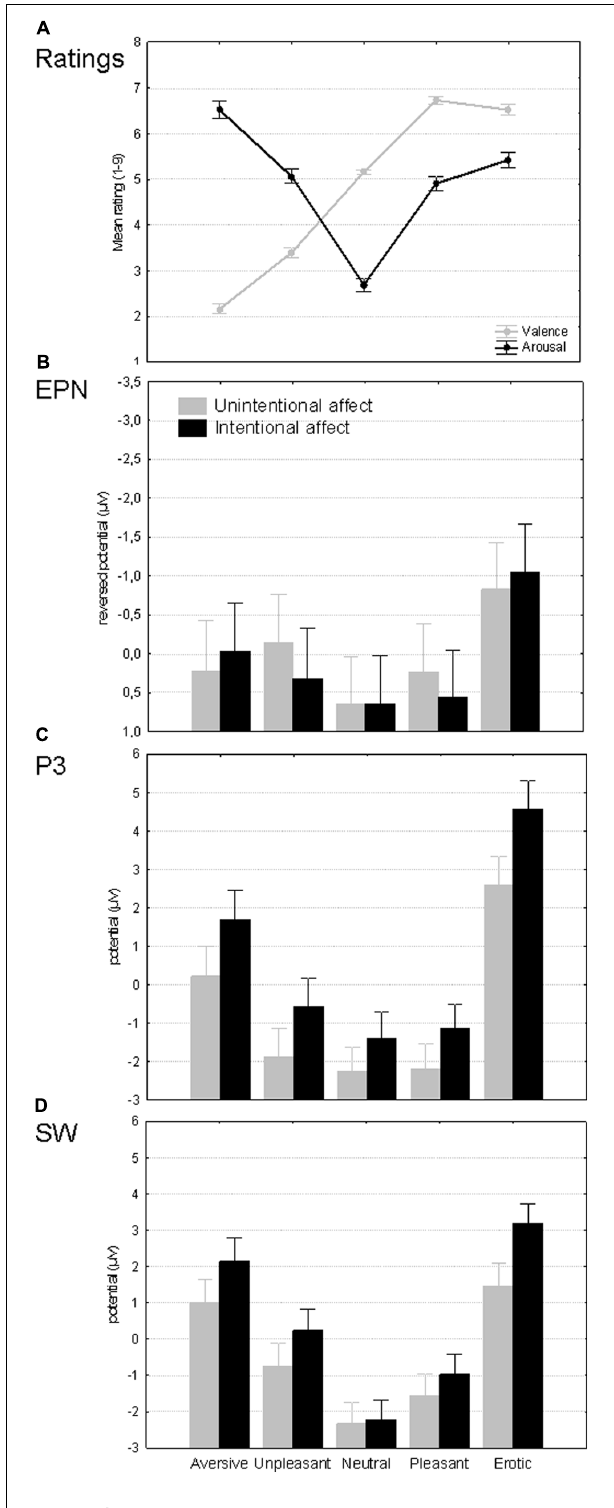
FIGURE 2 | Overview of the results. (A) Affective category effects on subjective valence and arousal ratings. (B–D) Affective category as well as intention effects on mean amplitudes of EPN (175–300 ms; reversed scale), P3 (300–500 ms), and slow wave (500–1500 ms). Spreads denote standard